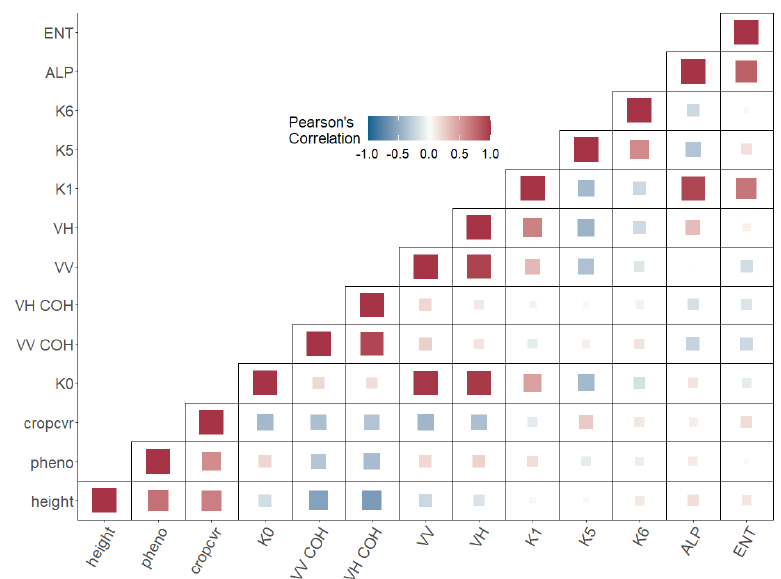
Figure 4. Correlation heatmap of wheat fields covered by this study showing potential information redundancies and statistically relevant